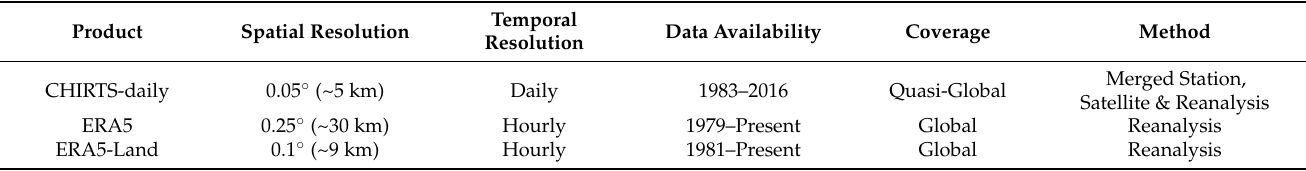
Table 2. Overview of gridded temperature